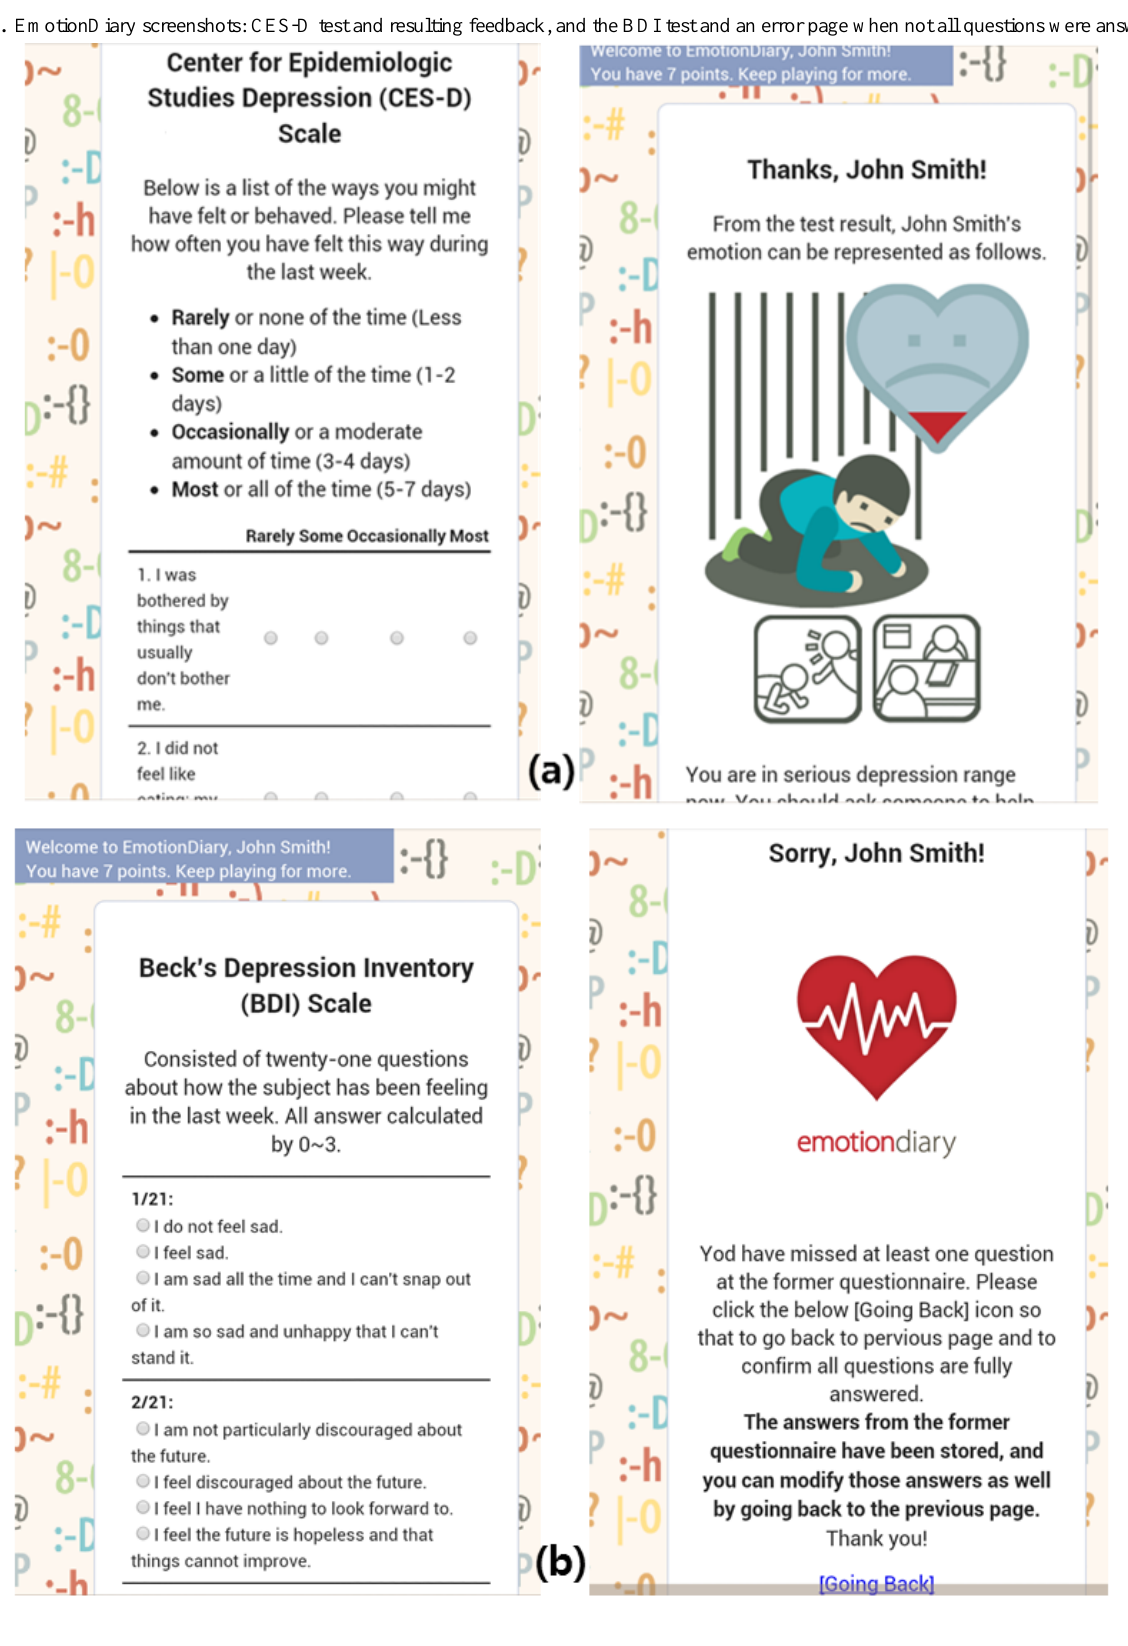
Figure 2. EmotionDiary screenshots: CES-D test and resulting feedback, and the BDI test and an error page when not all questions were